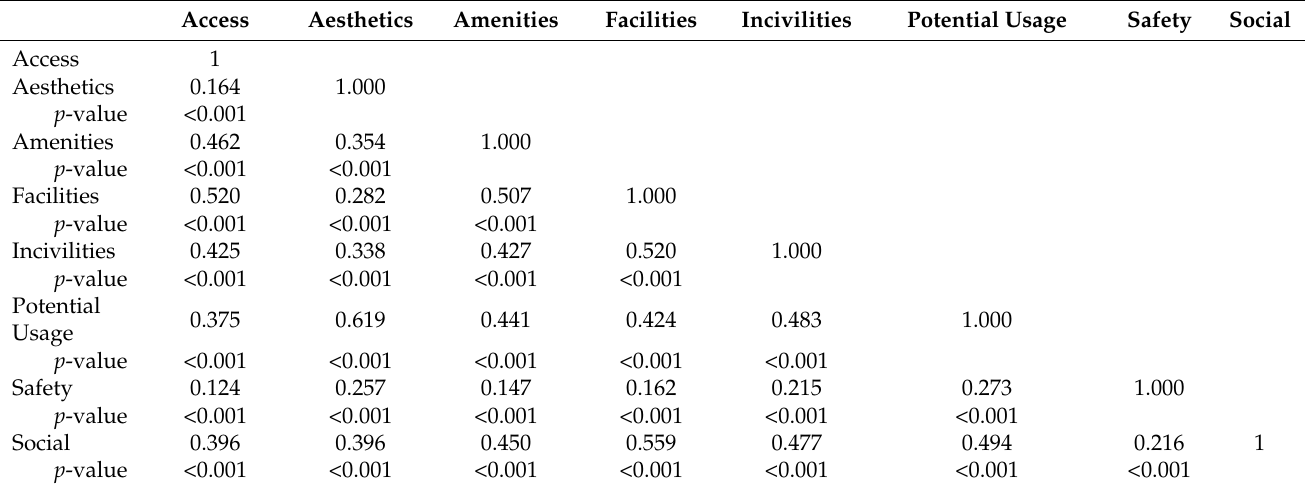
Table 2. Pearson’s correlation coefficients for quality domains of natural settings.